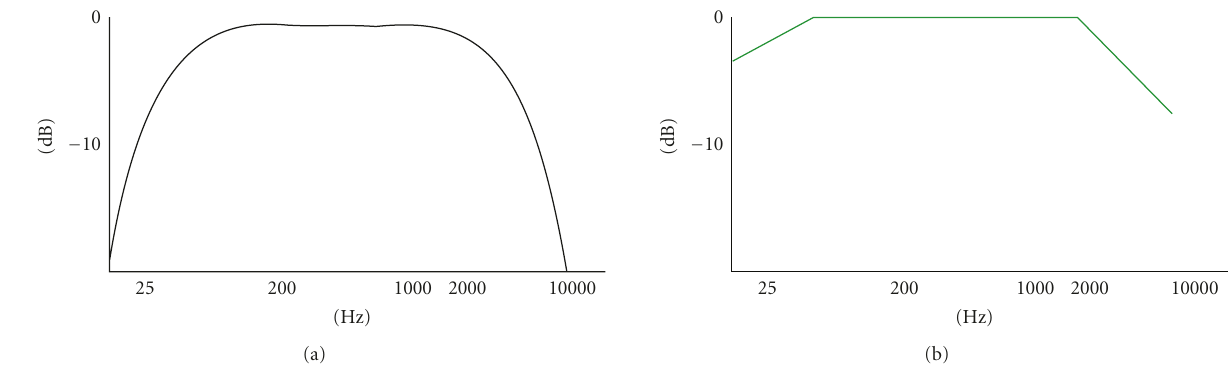
Figure 4: (a): bandwidth according to the A-curve. (b): bandwidth according to X-curve.